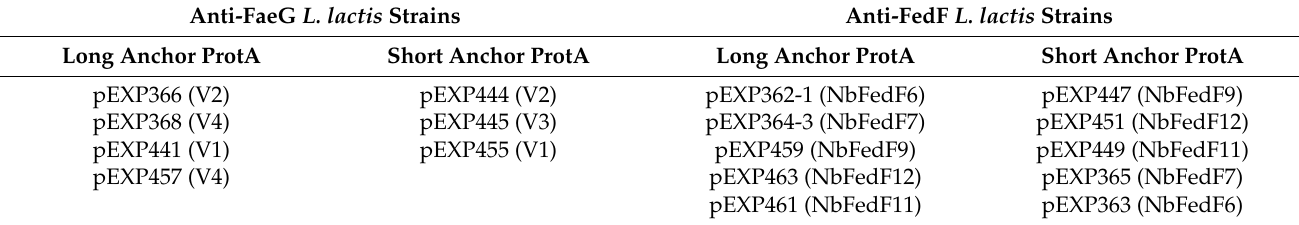
Figure 2. Cloning scheme for Nb surface display on L. lactis cell wall using ProtA anchor domain. Left: The pTRKH3 shuttle vector was adapted to the Gateway cloning system by inserting the pDEST14 cassette flanked by the attR1 and attR2 recombination sites, downstream of the cplC promoter sequence, in the ApaLI restriction site to form plasmid pHD669. The fusion gene comprised the UspA signal peptide sequence for Gram-positive bacteria (green), Nb (blue) sequence, and protein A anchor domain sequence (red). The C-terminus of protein A contained the LPXTG motif (X is any amino acid) that is recognized by sortase, a transaminopeptidase enzyme, that cleaves the protein A between the threonine and glycine residues of the motif and links it covalently to the pentaglycine peptide of the cell wall peptidoglycan. The pentaglycine peptide is an interbridge between the tetrapeptides that cross-link the N-acetylglucosamine (NAG) and N-acetylmuramic acid (NAM) polysaccharide chains to form the lattice-like structure of the cell wall. On the right is a schematic presentation of the anti-FaeG Nb (blue) in the complex with the FaeG subunit from F4 fimbriae (in grey is the immunoglobin like core and in red is the receptor binding domain) [41] anchored on the cell wall [51] by protein A (red) [52]. Table 2. Different recombinant L. lactis strains expressing Nanobodies against FaeG and FedF anchored on the cell surface via a short or long protein A protein linker.